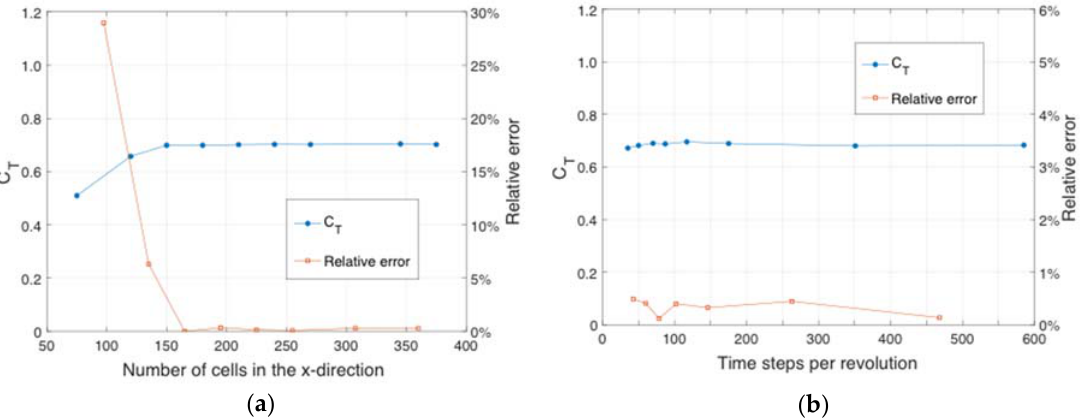
Figure 4. Resolution sensitivity of the VAT model: ( a ) Spatial resolution after 120 time steps per revolution; ( b ) Temporal resolution on a mesh with 150 cells in 𝑥 ‐ direction.